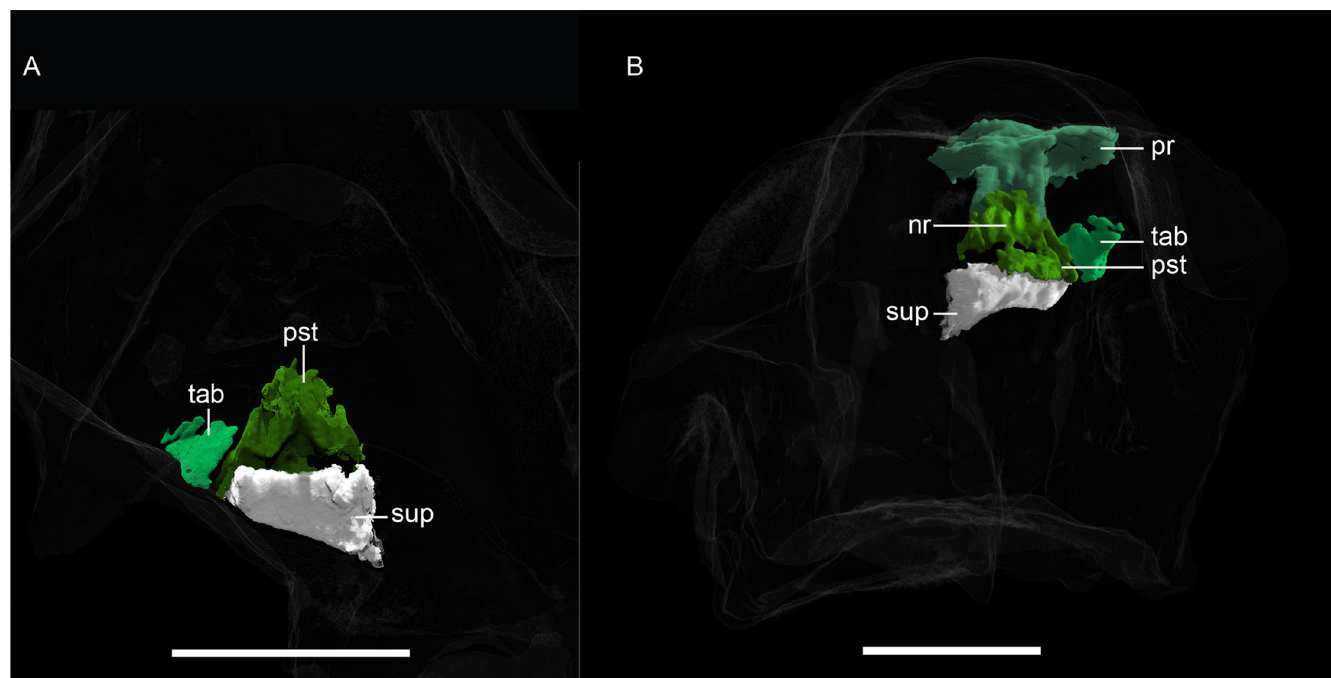
Fig 12. Neutron CT reconstruction of MB.R.999: rear end of skull roof from (A) ventral and (B) dorsal. Abbreviations: nr, nuchal ridge; pr, parietal; pst, postparietal; sup, supraoccipital; tab, tabular. Scale bars = 2